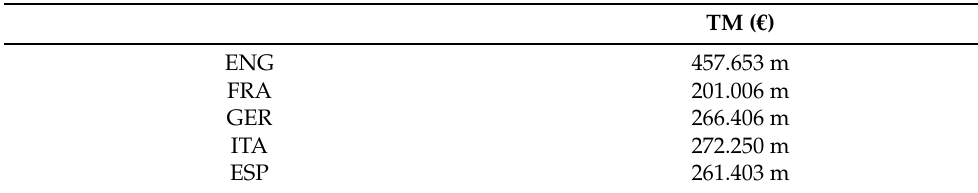
Table 11. Average values of the teams by